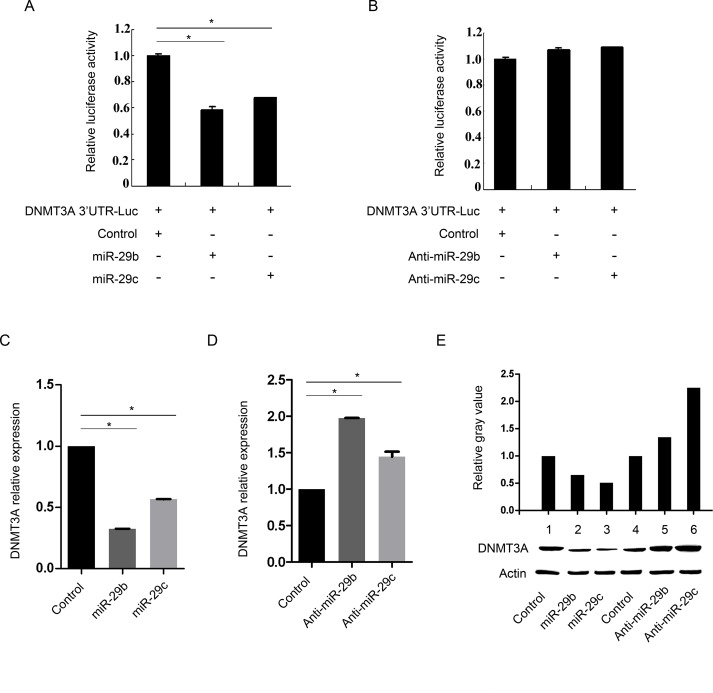
miR-29b/c directly targets DNMT3A.(A and B) Effects of miR-29b/c on the transcriptional activity of DNMT3A detected by luciferase assay. The 3’UTR of DNMT3A was cloned into the pGL3-basic luciferase reporter vector (DNMT3A 3’UTR-Luc), which was co-transfected with miR-29b/c mimics or negative control mimics (A), or miR-29b/c inhibitors or negative control inhibitors (B) into BGC-823 cells and assayed for luciferase activity. Firefly luciferase values were normalized to Renilla luciferase activity derived from pRL-TK and plotted as relative luciferase activity (*P<0.05). The results are expressed as the mean±s.d. of at least three independent experiments. (C and D) qRT-PCR analysis of the DNMT3A relative expression in BGC-823 cells transfected with miR-29b/c mimics (C)/inhibitors (D) or negative control oligonucleotide (*P<0.05). (E) Western blot analysis of DNMT3A expression in BGC-823 cells transfected with miR-29b/c mimics (lane 1, 2, 3) /inhibitors (lane 4, 5, 6) or negative control oligonucleotide. β-actin was used as a loading control. The band intensities were quantified and normalized to β-actin intensities with ImageJ software.